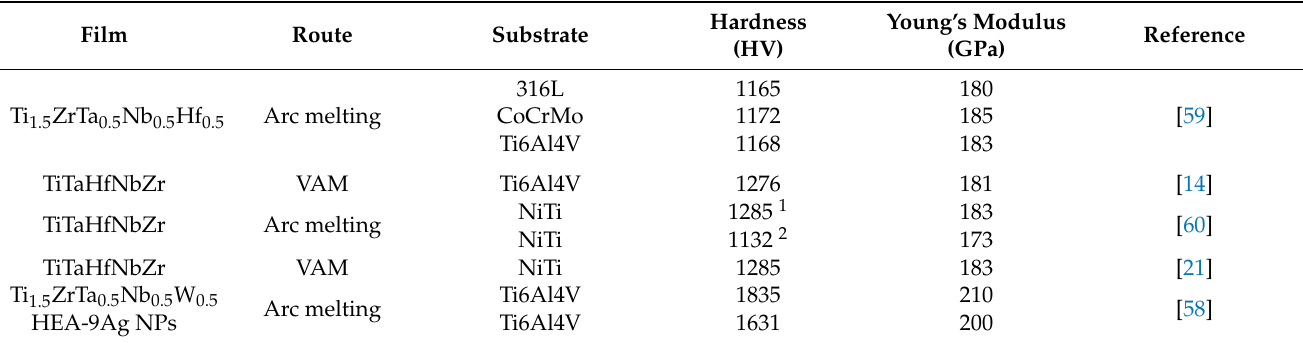
Table 6. Mechanical properties of amorphous phase